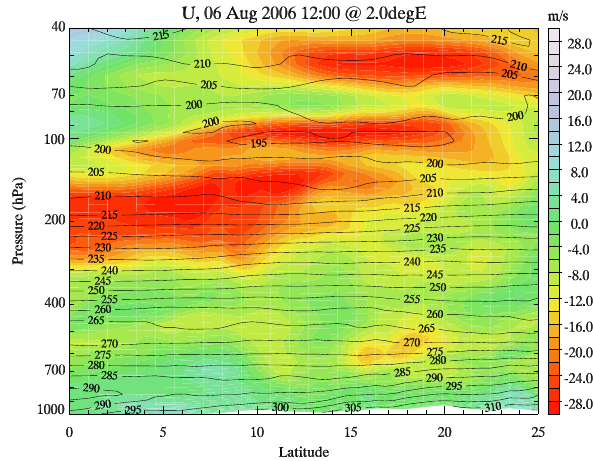
Fig. 4. ECMWF wind velocity and temperature (in K) analyses (vertical cross section for u -component) for 6 August 12:00UTC along 2 ◦